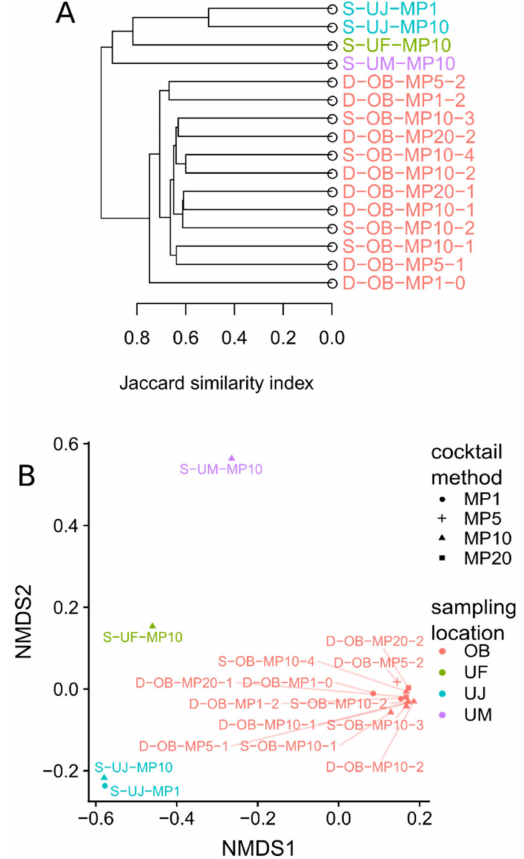
Figure 3. Jaccard Dissimilarity among replicated experiments and di ff erent samples. ( A ) Hierarchical clustering analysis of all Mimiviridae libraries. ( B ) Non–metric multidimensional scaling (NMDS) ordination of all MEGAPRIMER sequencing